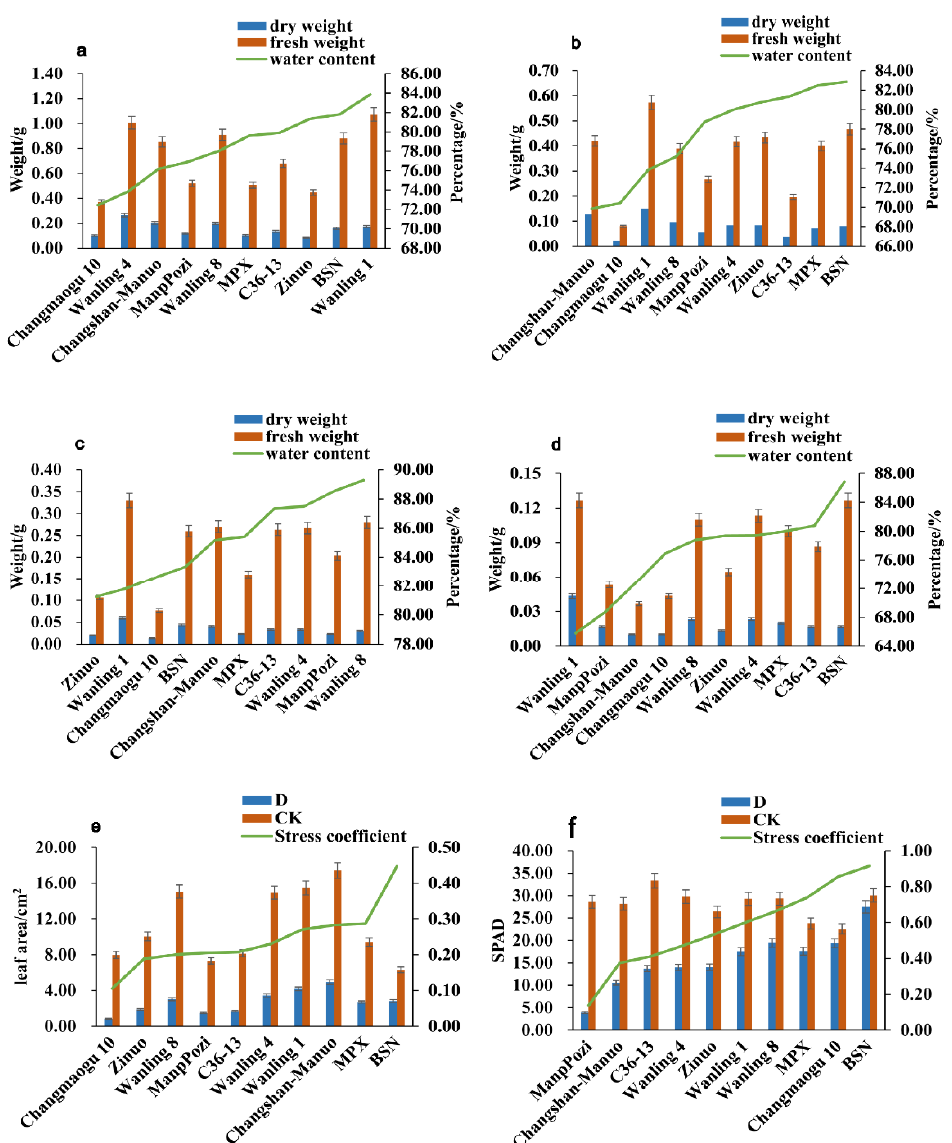
Figure 1. Identification of morphological indexes of ten Shanlan upland rice varieties. ( a ) Dry and fresh weight and water content of stems and leaves in the control. ( b ) Dry and fresh weight and water content of stems and leaves under drought treatment. ( c ) Dry and fresh weight and water content of roots in the control. ( d ) Dry and fresh weight and water content of roots under drought treatment. ( e ) Penultimate leaf area and stress coefficient under drought treatment and the control. ( f ) SPAD and stress coefficient under drought treatment and the